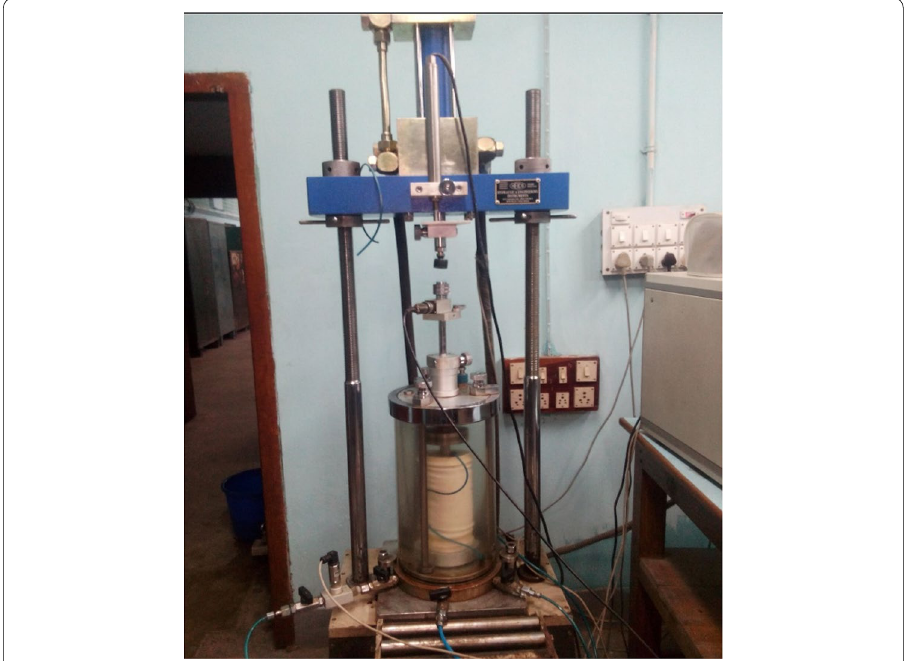
Fig. 6 Triaxial cell on the HEICO loading platformMap of West Bengal in India (source: